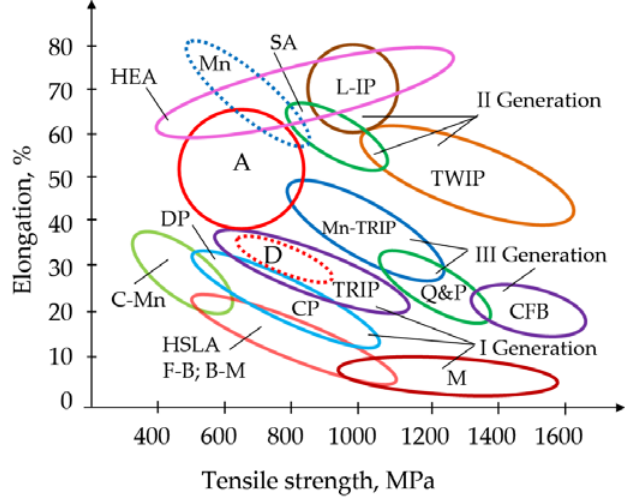
Figure 1. Mechanical properties of HSS and AHSS (Advanced High-Strength Steels) high-strength cold-resistant and cryogenic steels. Figure 1 contains the following designations: C-Mn—pearlitic steels; HSLA—high-strength